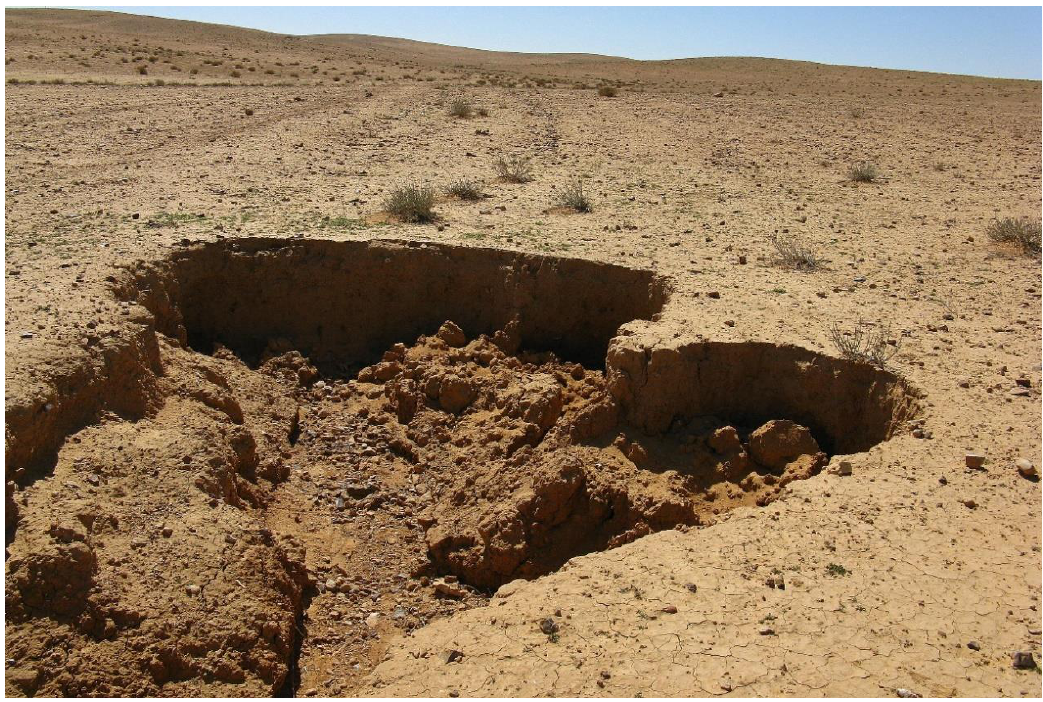
Figure 4. An active gully head eroding rangeland soil in the semi-arid ‘Badia’ of Jordan.